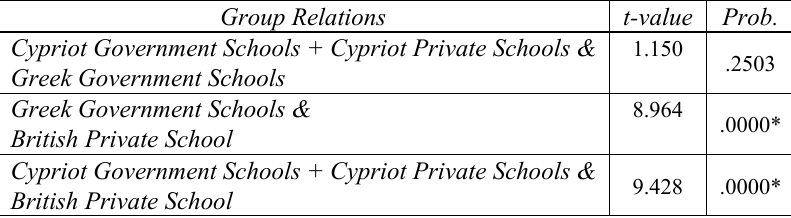
Table 5: Two sample t-test between the groups